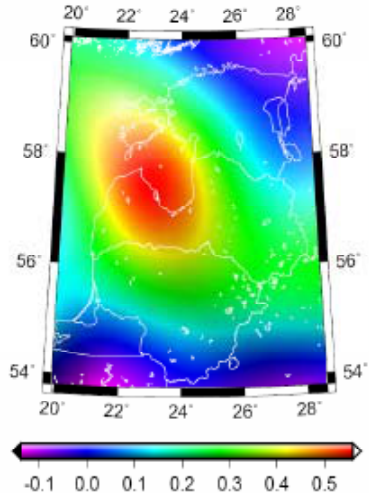
Fig. 2. Discrepancies between the spectral window 2-95 of the EIGEN-GL04c and EGM96 geoid models, ∆ N 2;95 . The discrepancies range from –0.14 m to +0.56 m with a mean of +0.21 m. Generally, the EIGEN-GL04c geoid appears to be higher than that of the EGM96 model. Standard deviation of the detected discrepancies amounts to 0.17